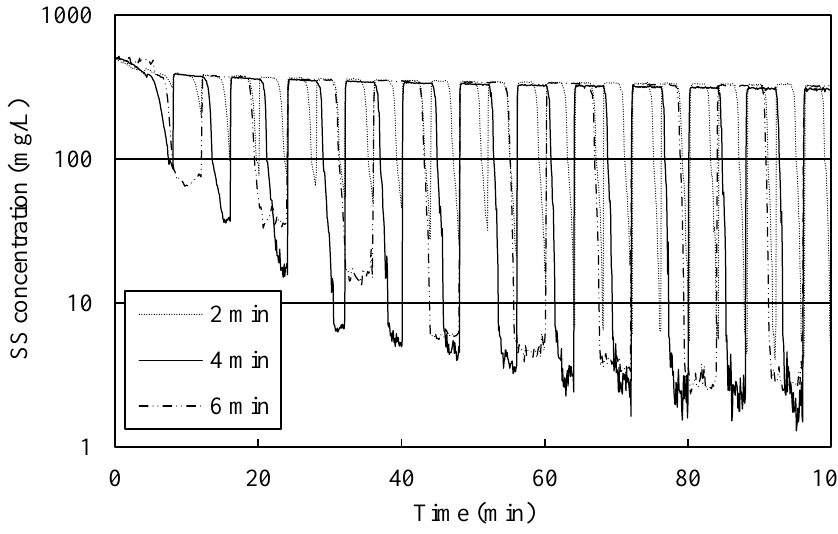
Figure 8. SS concentration variations with different intervals between agitation during intermittent agitation.